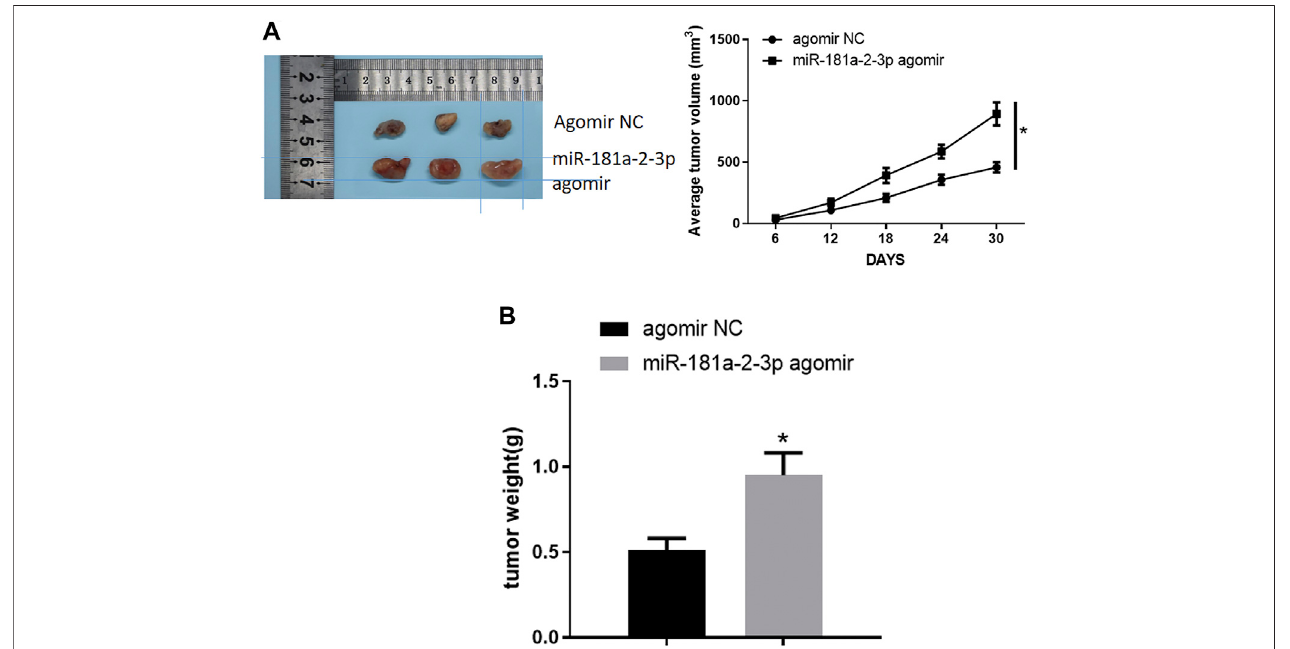
FIGURE 6 | miR-181a-2-3p facilitates tumor growth in vivo (A) Volume of mouse tumors; (B) Weight of mouse tumors; * p <